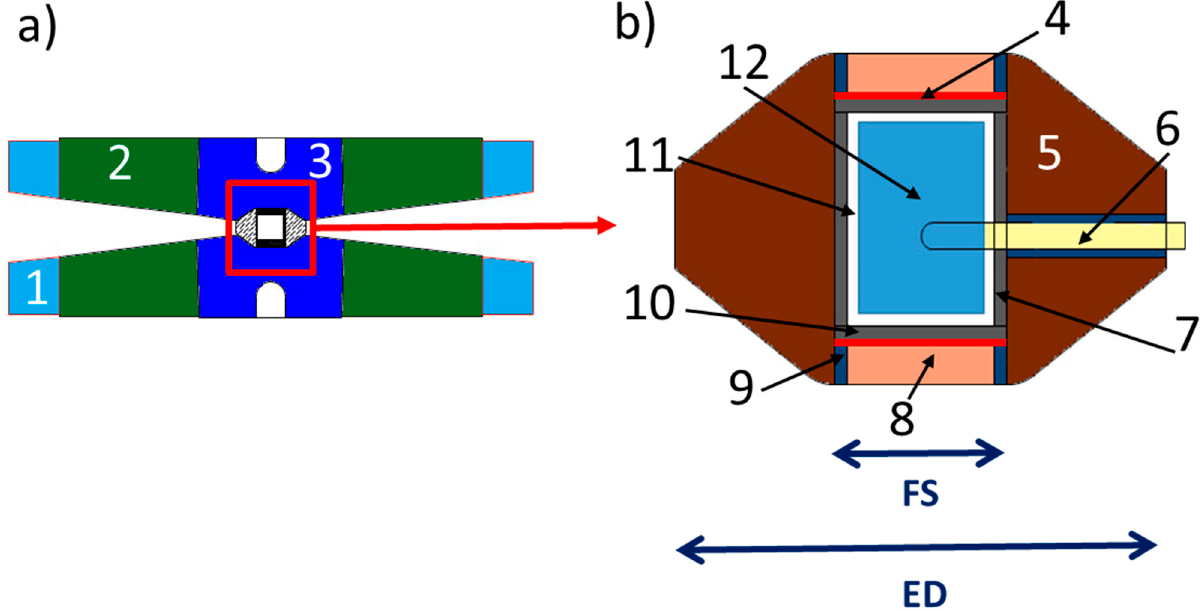
Figure 5. Schematic diagram of two-opposed anvils ( a ) and sample assembly ( b ) of the large volume Paris–Edinburgh press for in situ X-ray diffraction studies (here for ED = 10 mm and FS = 3.5 mm). (1) Cooling device. (2) Steel binding ring. (3) Tungsten carbide WC anvils. (4) Molybdenum disk. (5) Amorphous boron epoxy gasket (pressure medium). (6) Coaxial thermocouple. (7) Graphite heater. (8) Insulating ceramic. (9) Electrical contacts. (10) Graphite disk. (11) h-BN or MgO capsule. (12)